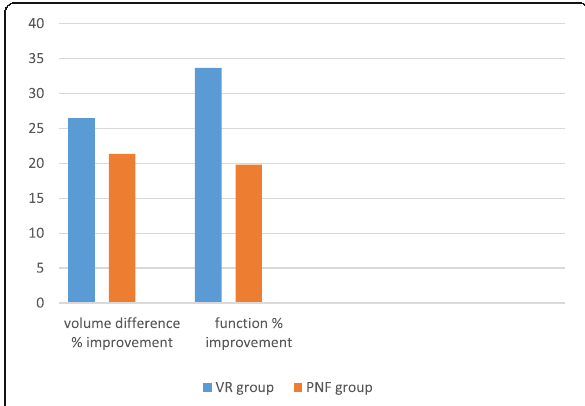
Fig. 2 The percentage improvement in all the measured variables between the two